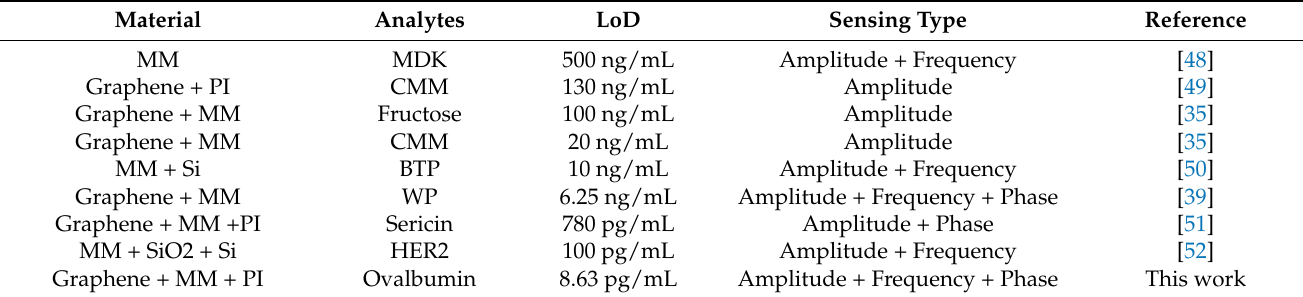
Table 1. Comparison of this study with previous THz biosensors.